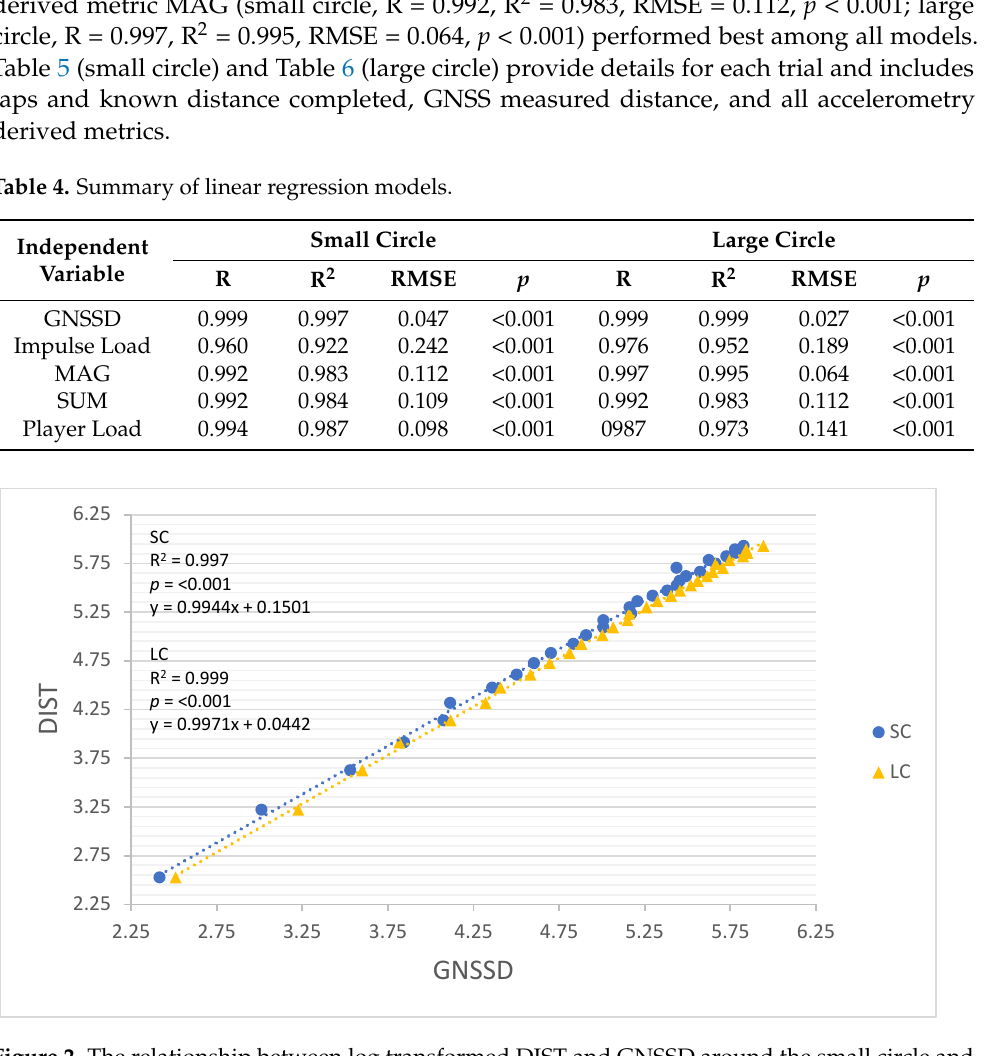
Figure 3. The relationship between log transformed DIST and IL around the small circle and the large circle. SC = small circle, LC = large circle.